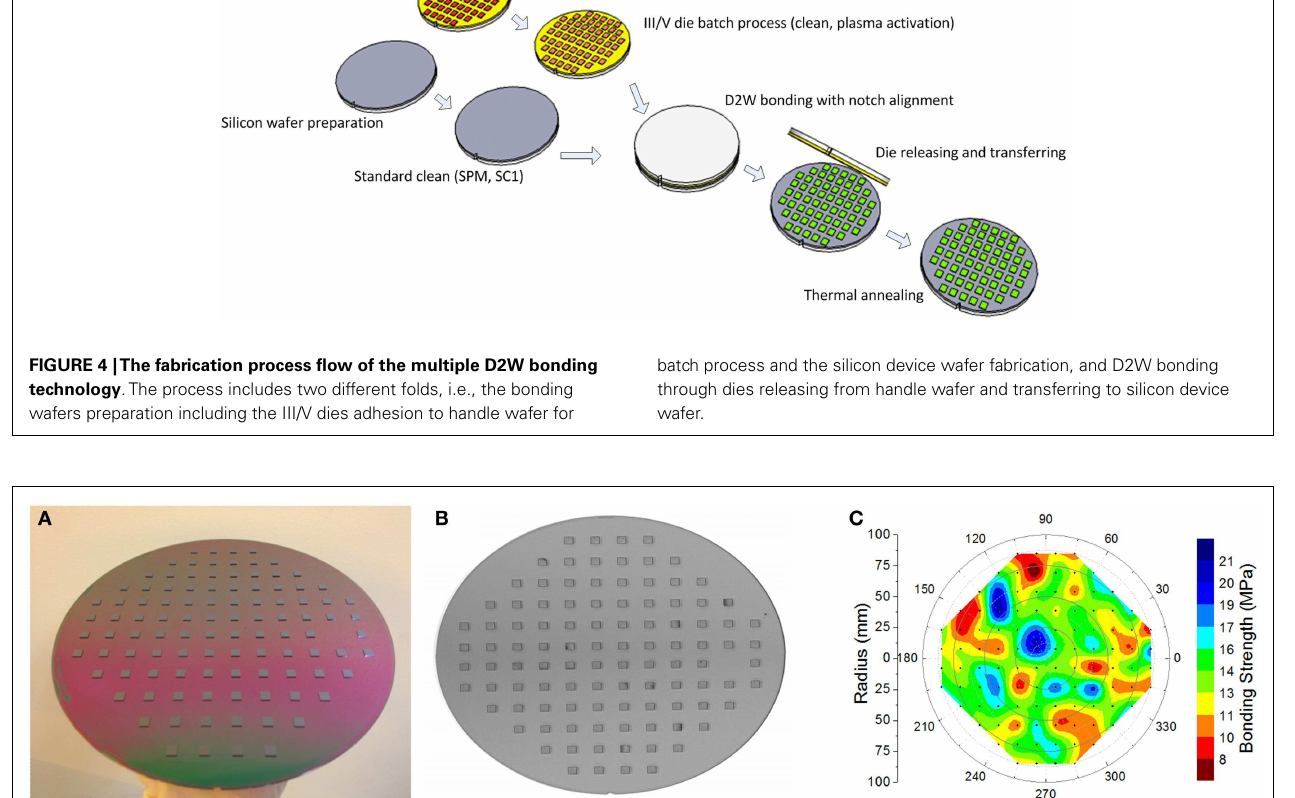
FIGURE 5 | Demonstration of 104 III/V dies bonding to silicon wafer . (A) Photo image of the bonded wafer, (B) CSAM results, (C) shear testing results.